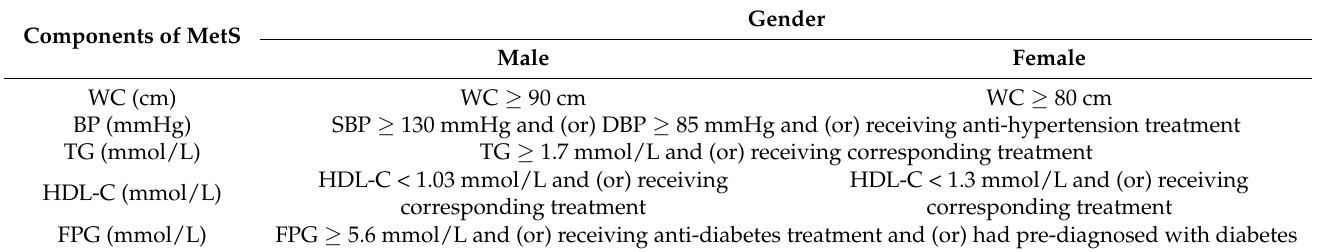
Table 1. Diagnostic standard of each component of MetS according to NCEP-ATP